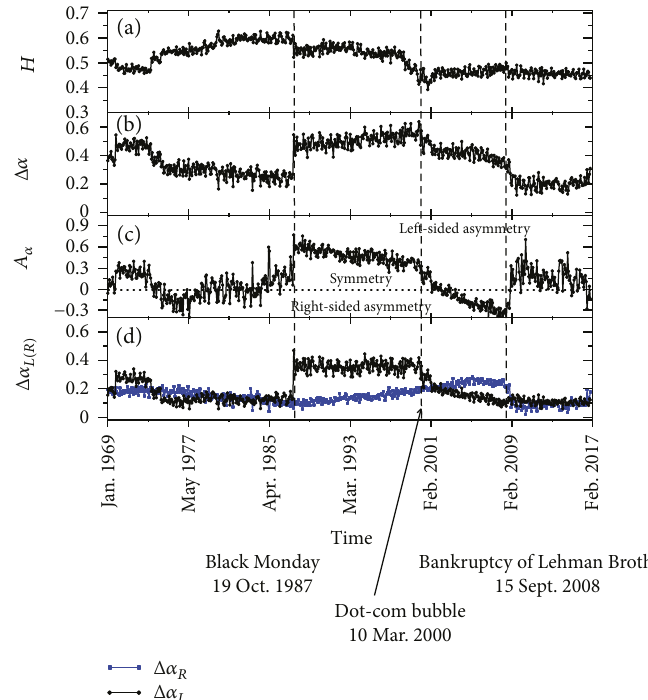
Δα α , and the widths L R for the time